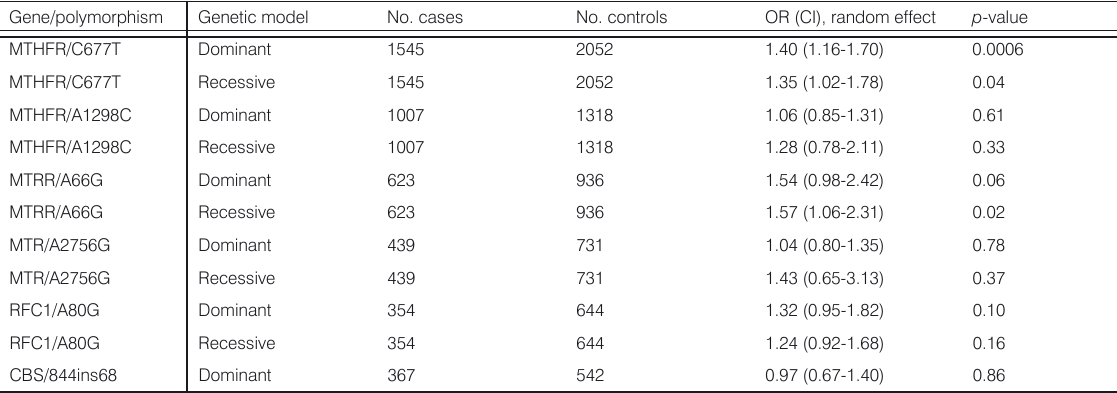
Table 1. Summary of results of the